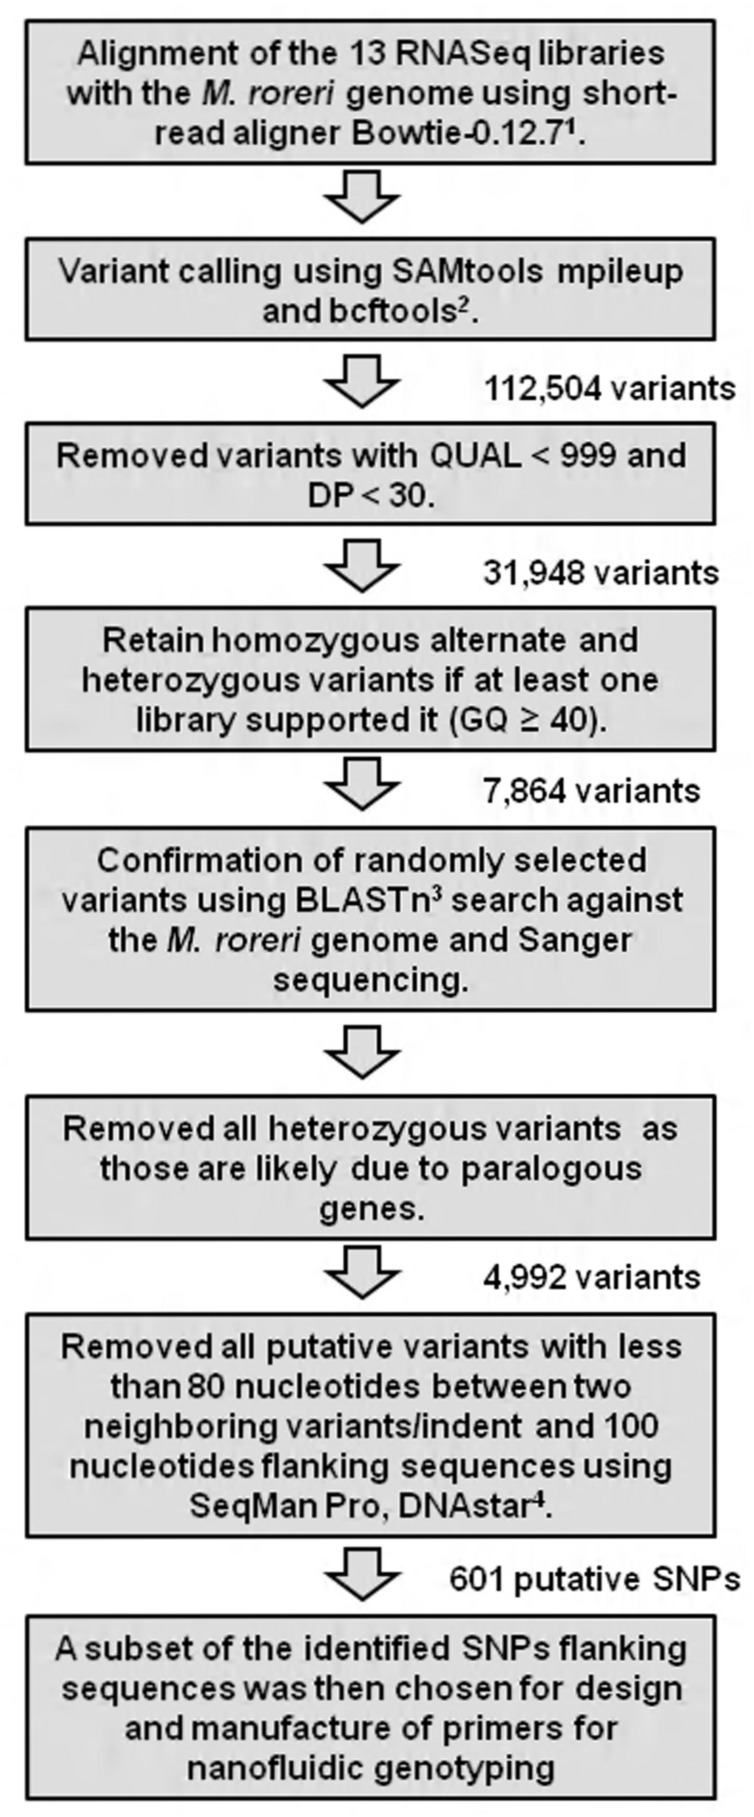
The overview of the single nucleotide polymorphism (SNP) mining strategy from Moniliophthora roreri RNASequencing (RNASeq) libraries. Each library from M. roreri isolates Co17, Co7, E18, Co15, E16, E43, C13, Co12, Co8, Co11, E32, P1, and MCA2977 was aligned against the M. roreri genome (Meinhardt et al., 2014) and variant calling was performed. Reference for bioinformatics tools: 1Langmead et al., 2009;2Li et al., 2009; 3Larkin et al., 2007, and 4DNASTAR, 1999. Abbreviation: QUAL (quality): Phred-scaled quality score for the assertion made in alternate base; DP: Combined depth across samples; GQ: Conditional genotype quality.